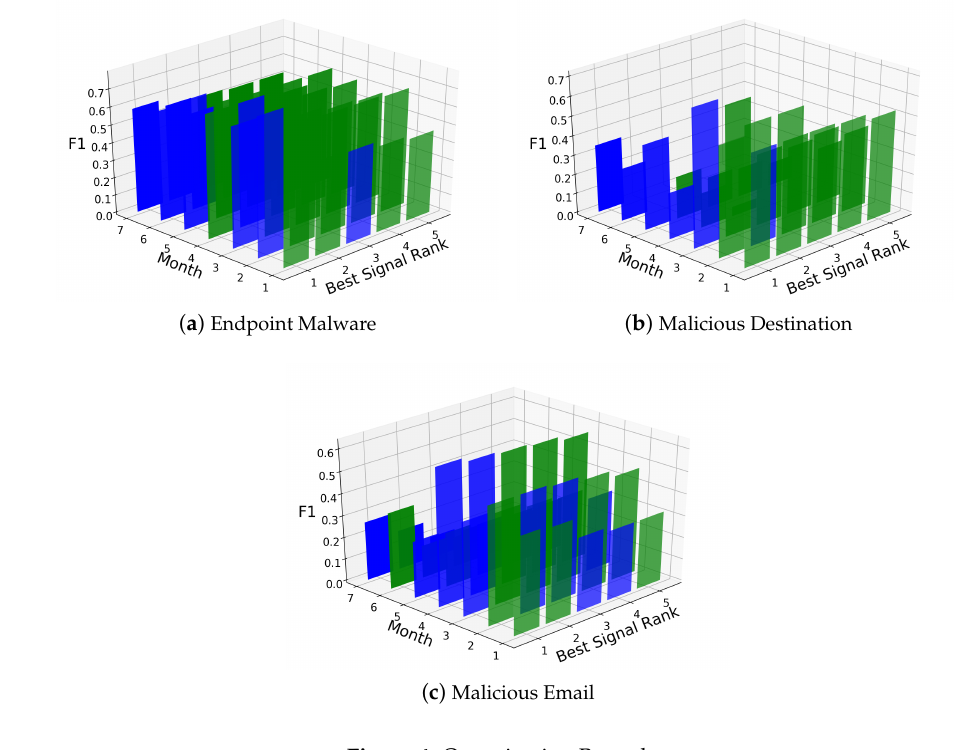
Figure 4. Organization B